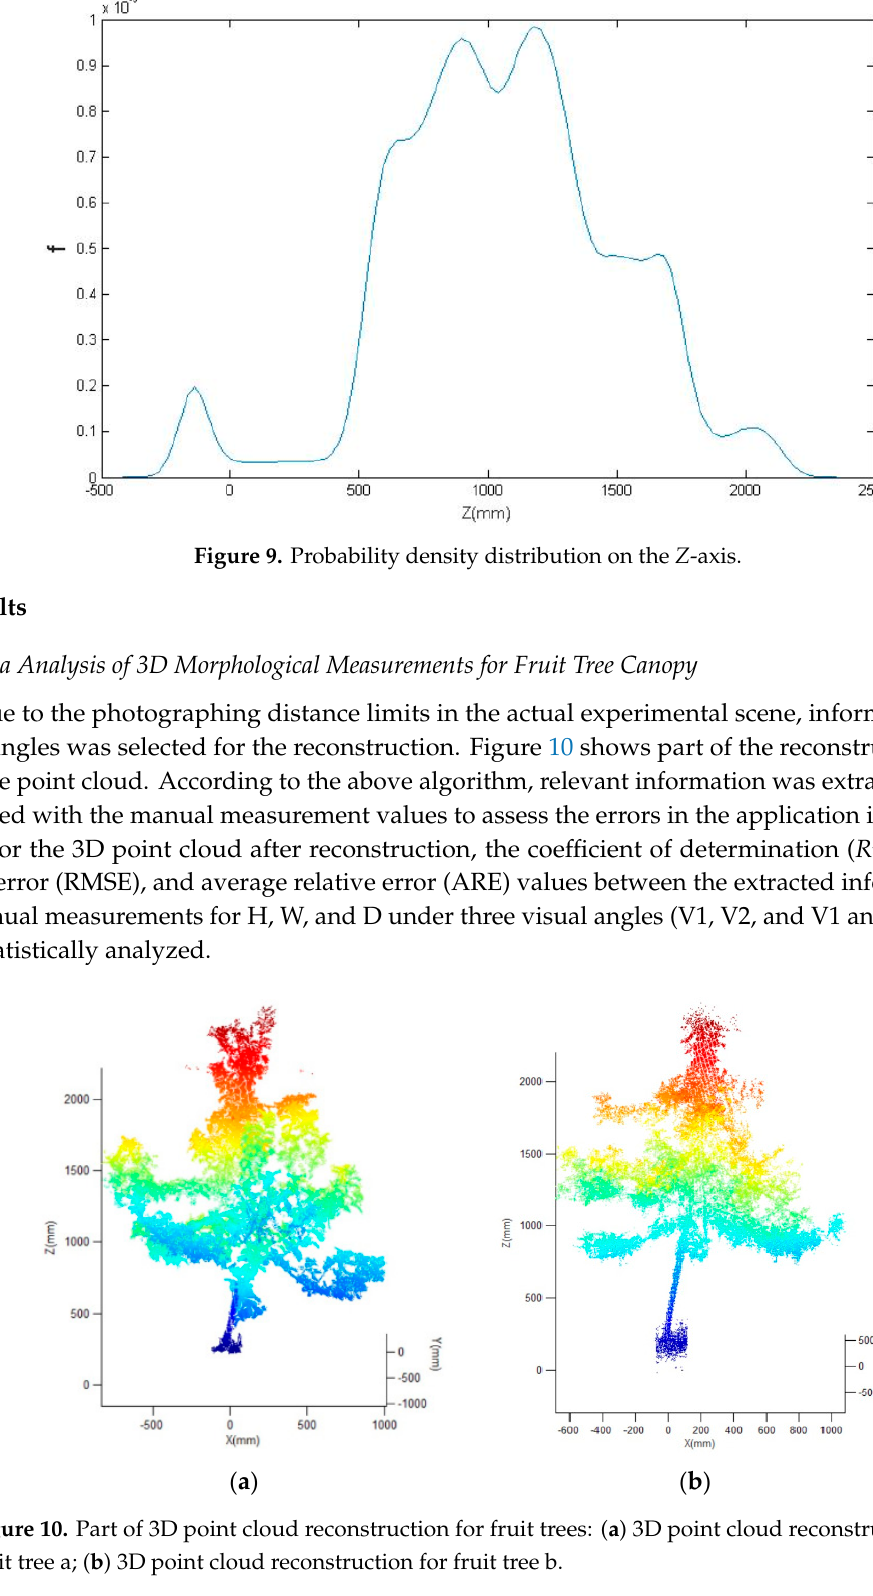
( c ) Figure 11. Measured and calculated values for H, W and D: ( a ) data comparison between the manually measured values and the calculated values for the fruit tree canopy H; ( b ) data comparison between the manually measured values and the calculated values for the fruit tree canopy W; ( c ) data comparison between the manually measured values and the calculated values for the fruit tree canopy D. 3.2. Error Analysis of 3D Morphological Measurements for Fruit Tree Canopy Since 32 fruit tree samples were reconstructed under three modes (single visual angle V1, single visual angle V2, and double visual angles V1 and V2 merged). The mean values of the coefficient of determination ( R 2 ), RMSE (root mean square error) values and ARE (average relative error) values for H, W, and D between calculation and the manual measurement were shown in Table 1.